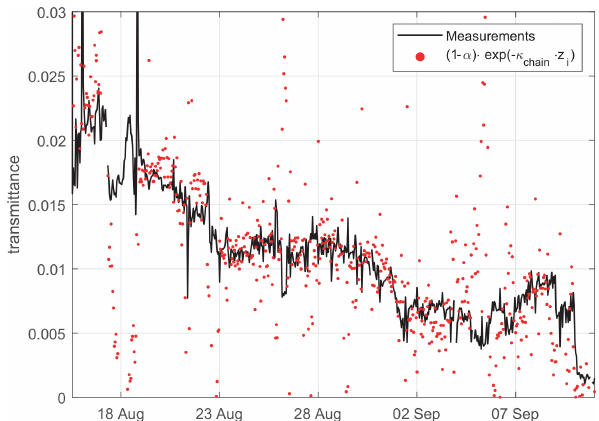
Figure 12. Time series of sea ice light transmittance as observed by the traditional RAMSES setup (black line) and a simple light chain data assisted exponential parameterization (red points) based on observed albedo and diffuse attenuation coefficients. The high scatter of the parameterizations is caused by scatter in the albedo data measured by the RAMSES